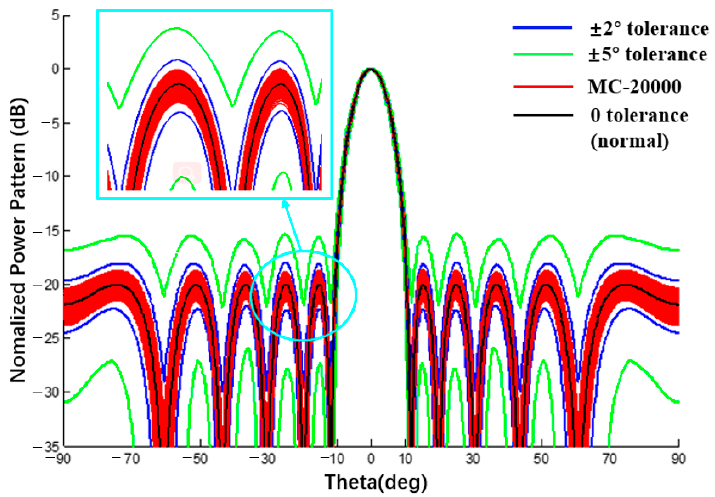
Figure 13. Linear array antenna pattern with excitation amplitude tolerance (Plane E, Dolph–Che- byshev excitation, the tolerance of MC method is 1%).